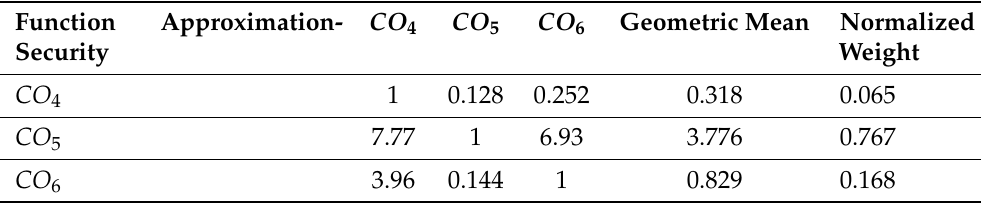
Table 13. Comparison between suitable components for function approximation with respect to